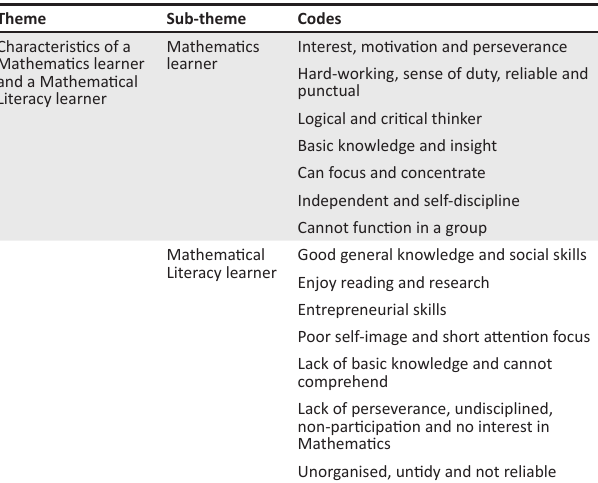
TABLE 3: Themes, sub-themes and